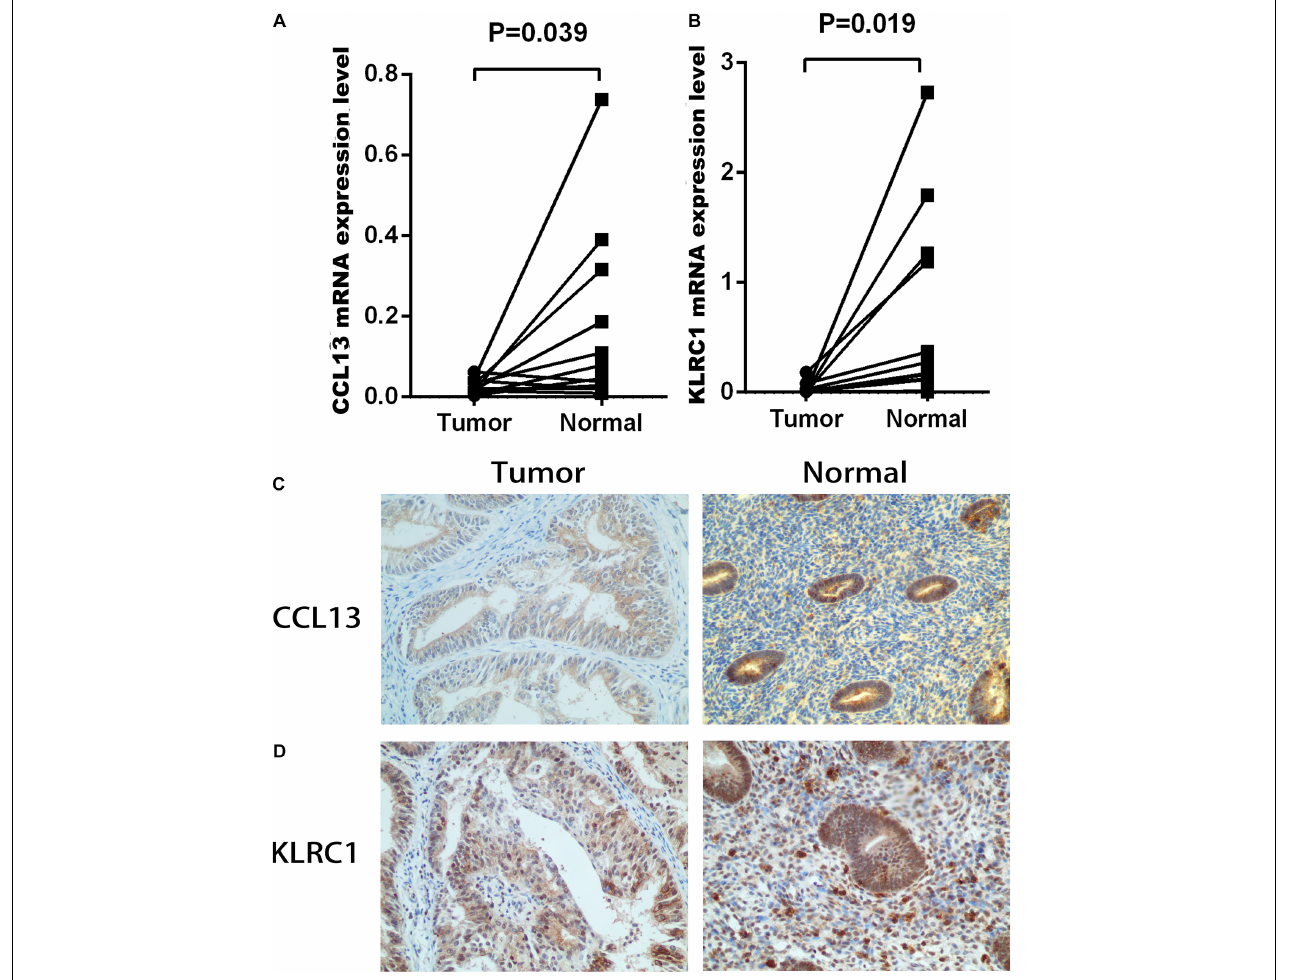
FIGURE 4 | The mRNA and protein expression level of CCL13 and KLRC1 in UCEC tumor and the adjacent tissues. (A,B) The mRNA expression of CCL13 and KLRC1 in UCEC tumor and the adjacent tissues. (C,D) The protein expression of CCL13 and KLRC1 in UCEC tumor and the adjacent tissues observed using